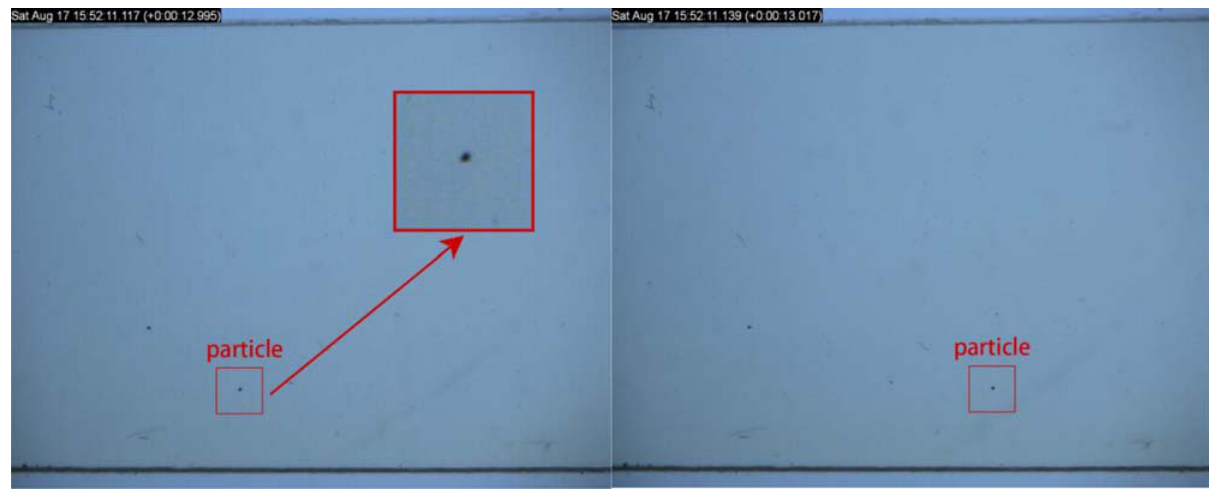
Fig. 7. Original images of